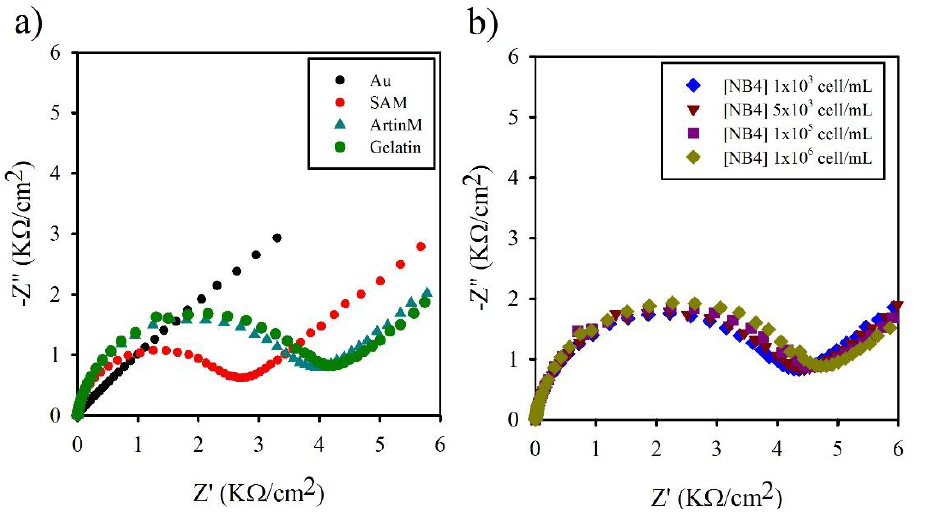
Figure 2. Determination of the ArtinM–NB4 interaction by EIS. Nyquist plots of impedance spectra were constructed by formation of the SAM, the immobilization of ArtinM, and blocking with gelatin ( a ), and by addition of different concentrations of NB4 cells ( b ). The impedance spectra were recorded in the presence of 1 mmol/L [Fe(CN) 6 ] 3−/4− as the redox probe in a KNO 3 1 mol/L as a supporting electrolyte, and were conducted in a frequency range of 0.01 Hz to 1 MHz, in the fixed potential of ~0.22 V vs . Ag|AgCl, and at an amplitude of 10 mV. 𝑍′′ is the imaginary and 𝑍′ is the real part of impedance. 𝑅 was measured from 𝑐𝑡 approximation of the diameter of the semi-circle of real part of impedance, 𝑍′ .